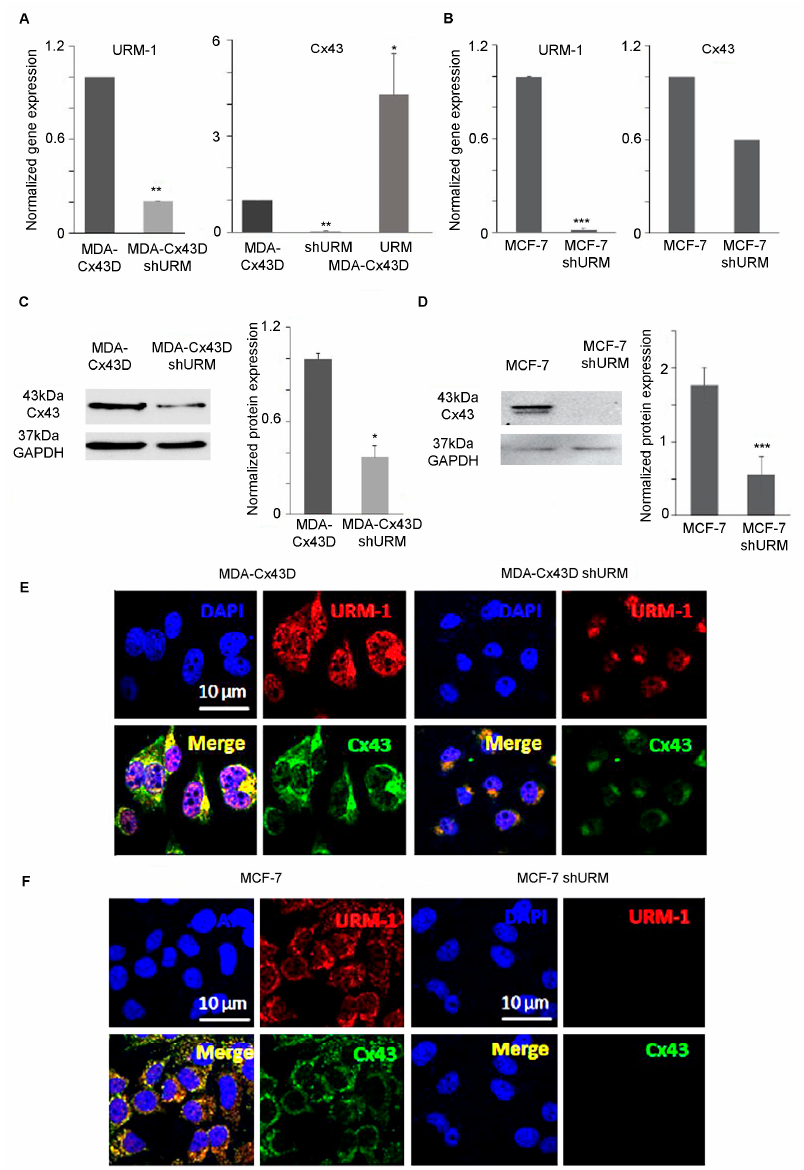
Figure 2. Downregulation of URM-1 regulates Cx43 in breast cancer cells. ( A ) Bar graphs display normalized mRNA expression levels of URM-1 and Cx43 in MDA-Cx43D, MDA-Cx43D shURM, and MDA-Cx43D URM, as detected by qPCR. Downregulation of URM-1 resulted in